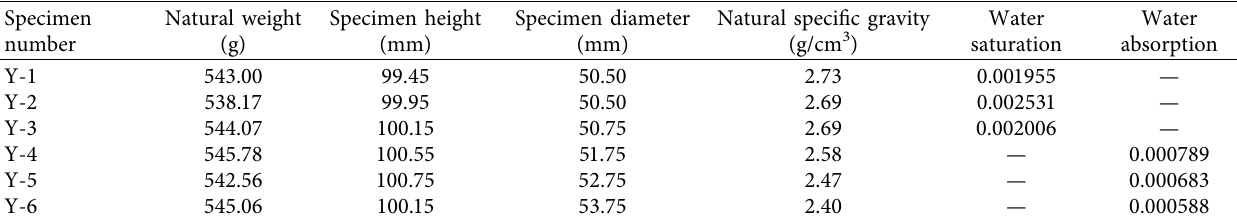
Table 1: Physical parameters of granite in natural and saturated